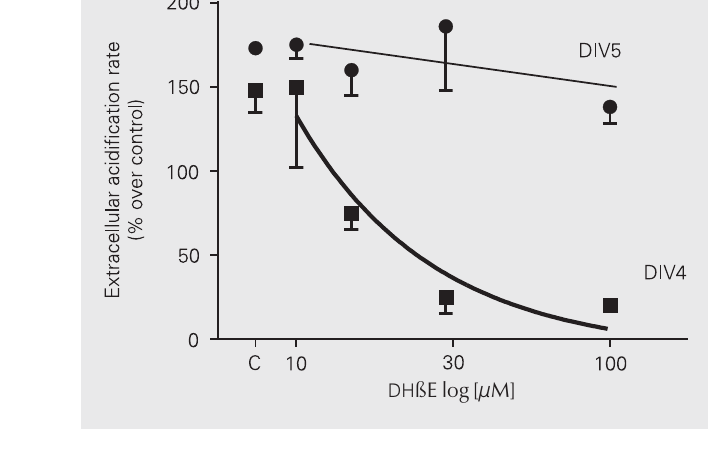
Figure 4. Blockade of acetylcho- line-induced increase in extra- cellular acidification rate of reti- nal cells in culture by α -bungaro- toxin. Retinal cells cultured for 4 (DIV4, left panel) or 5 (DIV5, right panel) days in vitro were stimulated with acetylcholine (ACh) in the presence (filled symbols) or absence (open symbols) of 10 nM α -bungaro- toxin and incubated for 1 h. Data are reported as means ± SEM. α -Bungarotoxin inhibited the re- sponse in DIV5 cultures (N = 4, P < 0.01) but not in DIV4 cul- tures (N = 5) (two-way